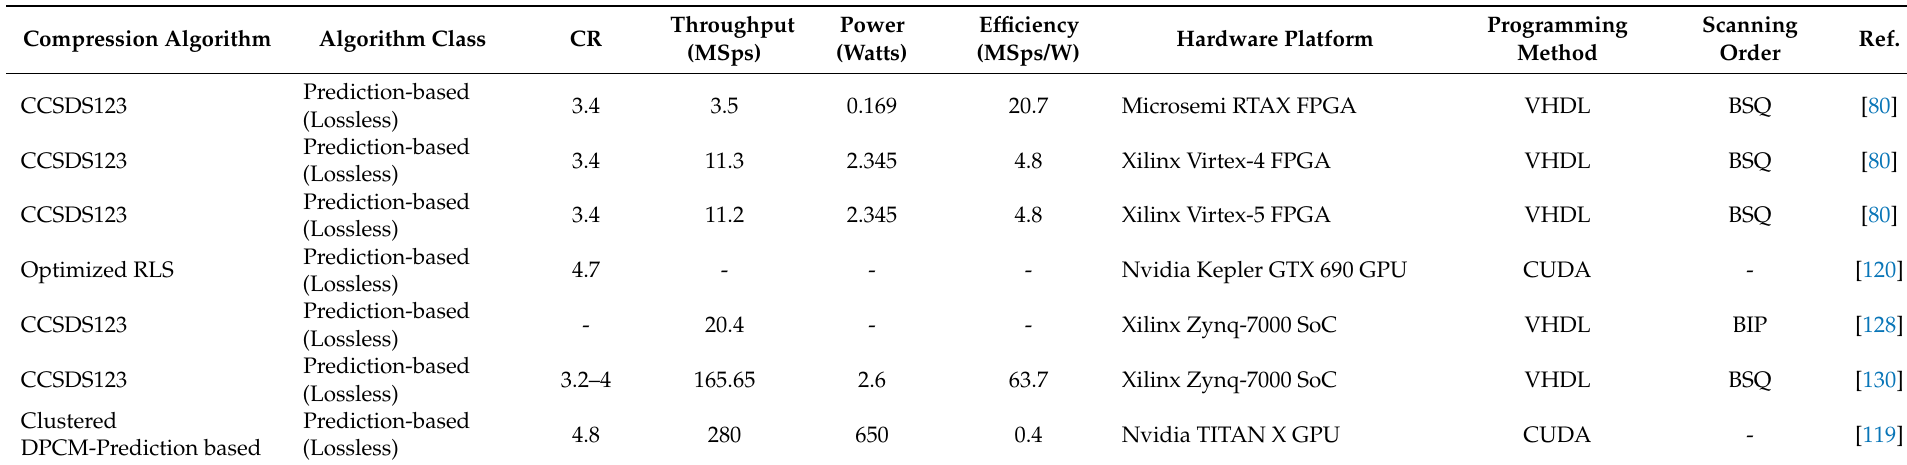
Table 11. Comparison of the proposed compression system validated using the AVIRIS Yellowstone